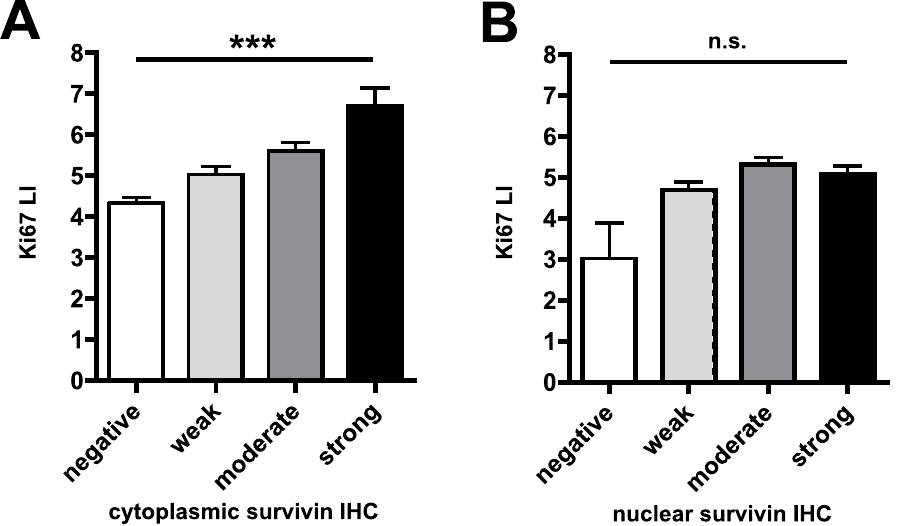
Figure 3. Association of Ki67 Labeling Index (LI) with subcellular survivin staining. Cytoplasmic but not nuclear survivin immunohistochemistry intensities correlate with the percentage of Ki67 positive tumor cells in